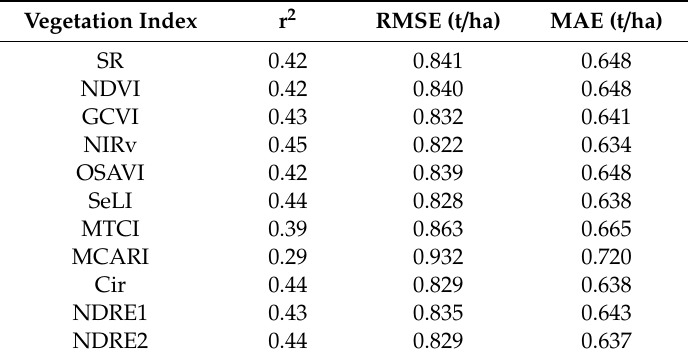
Table 5. Sentinel-2 Vegetation Index Performance. Validation statistics reported from performance on held-out validation set for a suite of vegetation indices.